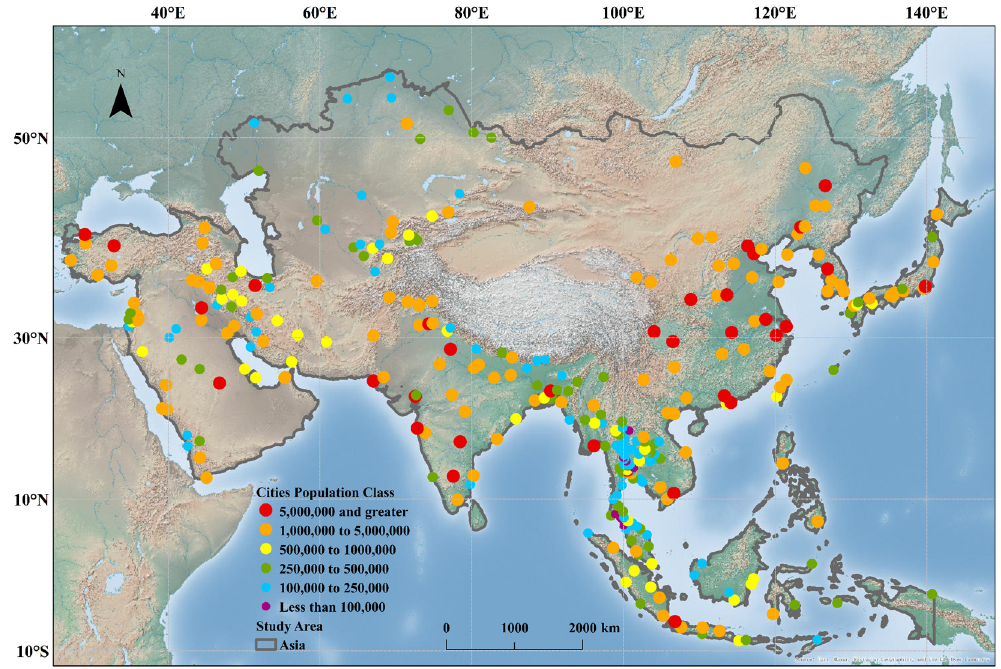
Figure 1. Location map of Asia and major cities.